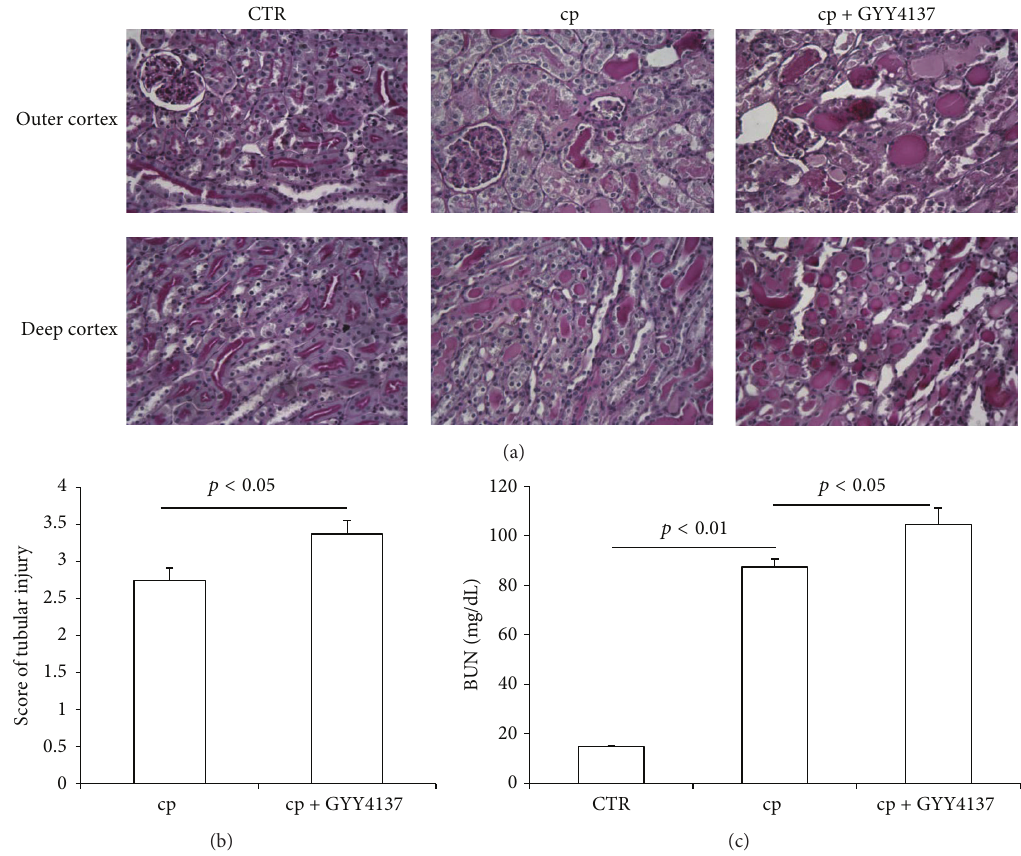
Figure 1: Effects of GYY4137 on renal function and tubular injury following cisplatin treatment. (a) Representative images of periodic acid- Schiff staining ( × 400) of kidneys. (b) Tubular injury score. (c) BUN levels. CTR: control, 𝑛 = 5 ; cp: cisplatin, 𝑛 = 10 ; and cp + GYY4137: cisplatin + GYY4137, 𝑛 = 10 . Data are means ±